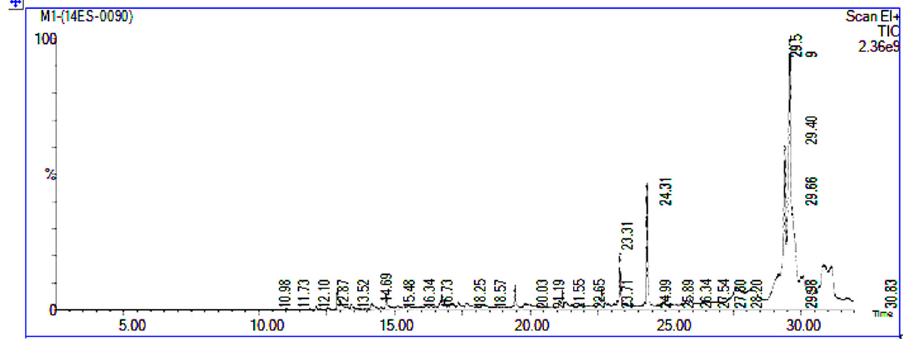
Figure 8: GC - MS analysis of identi fi ed chemical compounds in methanol leaf extracts of C. baccifera